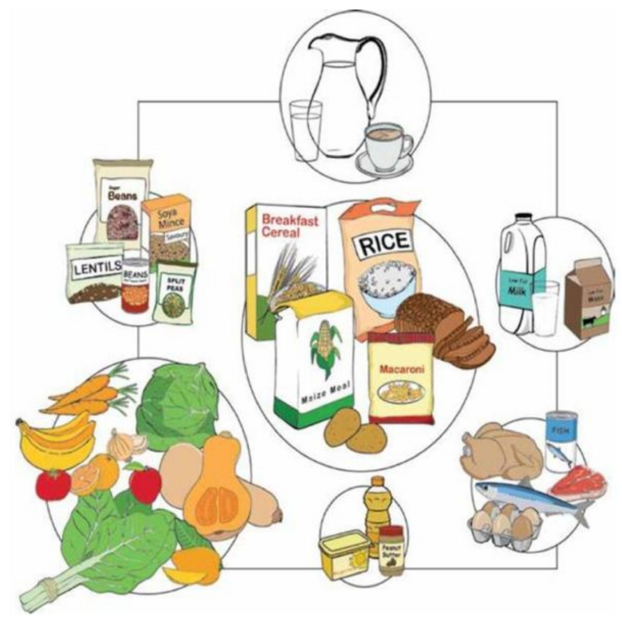
Figure 5. Food-based dietary guidelines (South Africa) [3].